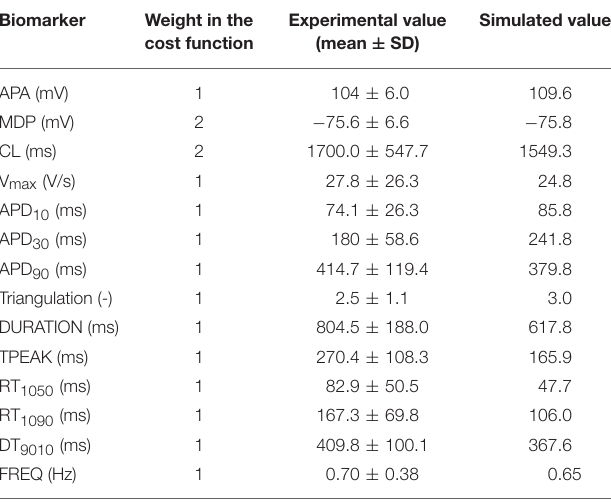
Comparison between the simulated biomarkers and the experimental ones used for the model parameter optimization. AP biomarkers: AP amplitude (APA), maximum